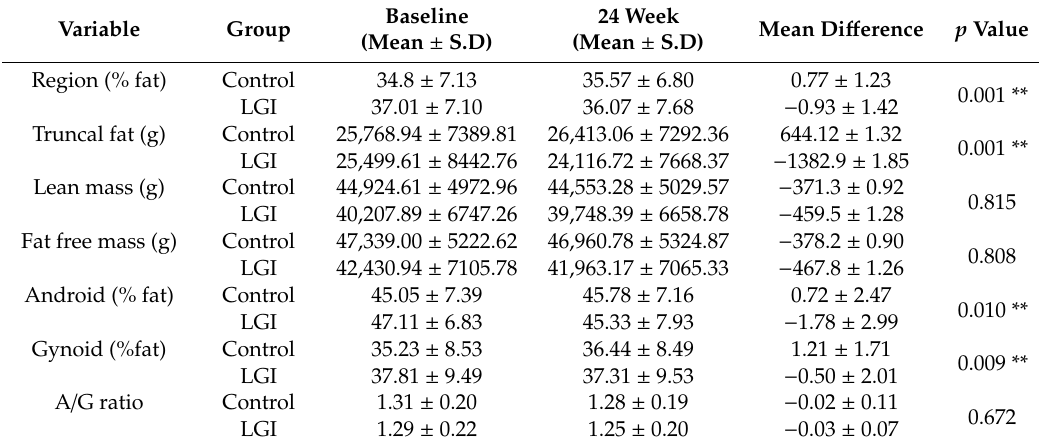
Table 5. Comparison of di ff erences between baseline and 24 weeks in body composition measurements between the LGI and control groups